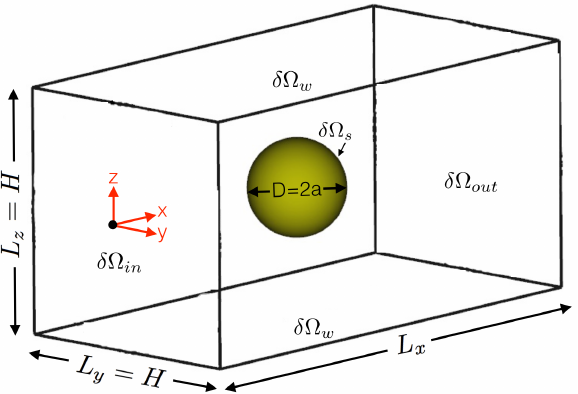
Figure 1. Schematic illustration of the computational domain (square duct) used to simulate the viscoelastic fluid flow past a